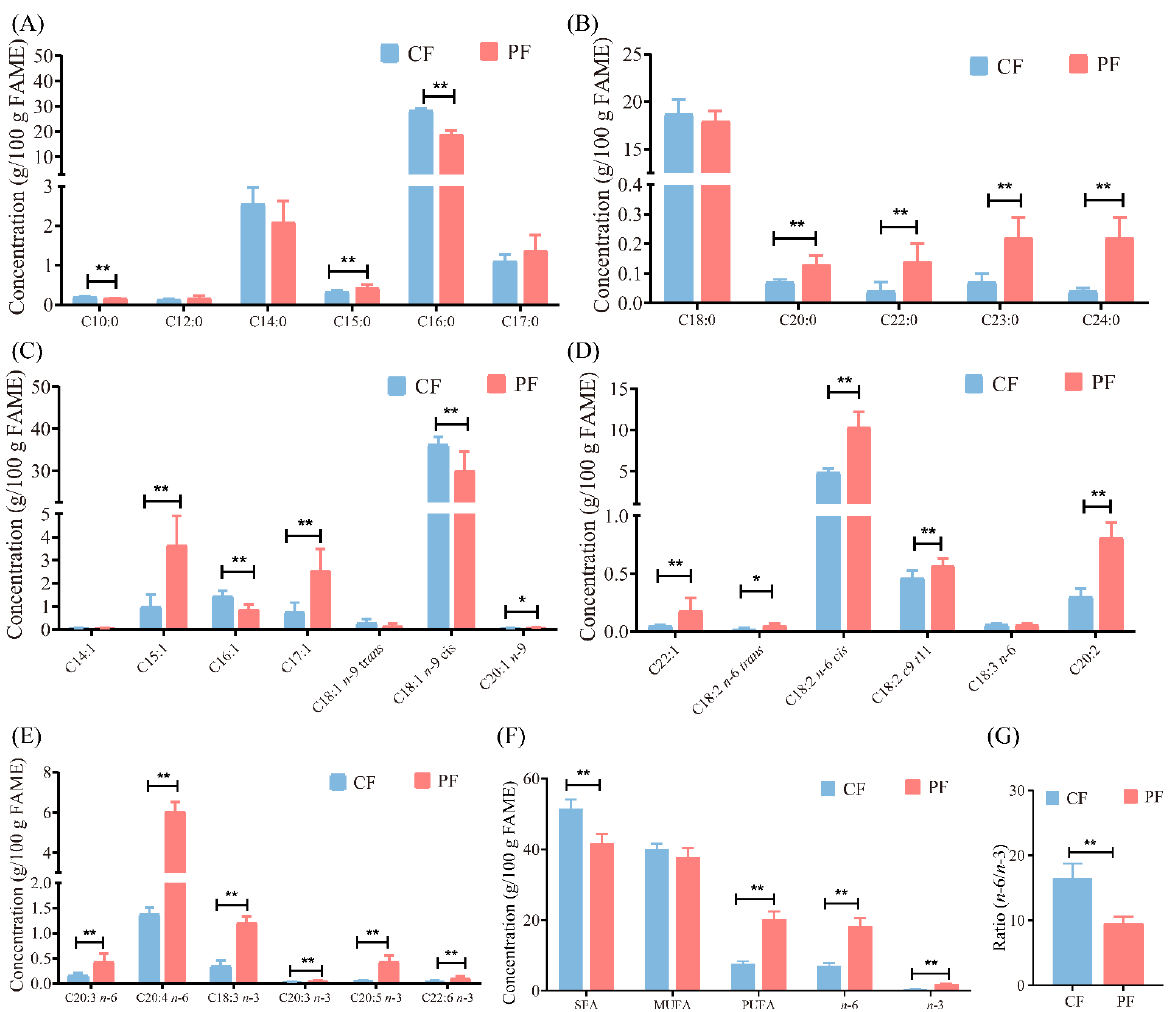
Figure 2. Comparison of fatty acid composition in concentrate-fed (CF) and pasture-fed (PF) groups ( n = 8). ( A – E ) Concentrations of the fatty acids detected. ( F ) Contents of SFA, MUFA, PUFA, n -6 and n -3 PUFA in lamb. ( G ) The ratio of n -6 to n -3 PUFA. SFA, saturated fatty acids, MUFA, monounsaturated fatty acids, PUFA, polyunsaturated fatty acids. * p < 0.05, ** p < 0.01.